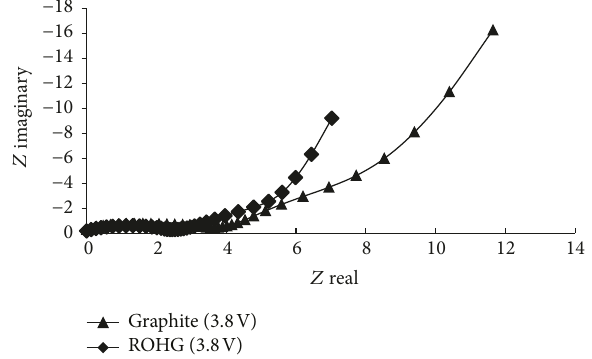
Figure 5: Electrochemical impedance spectra for ROHG and graphite (at 3.8 V).